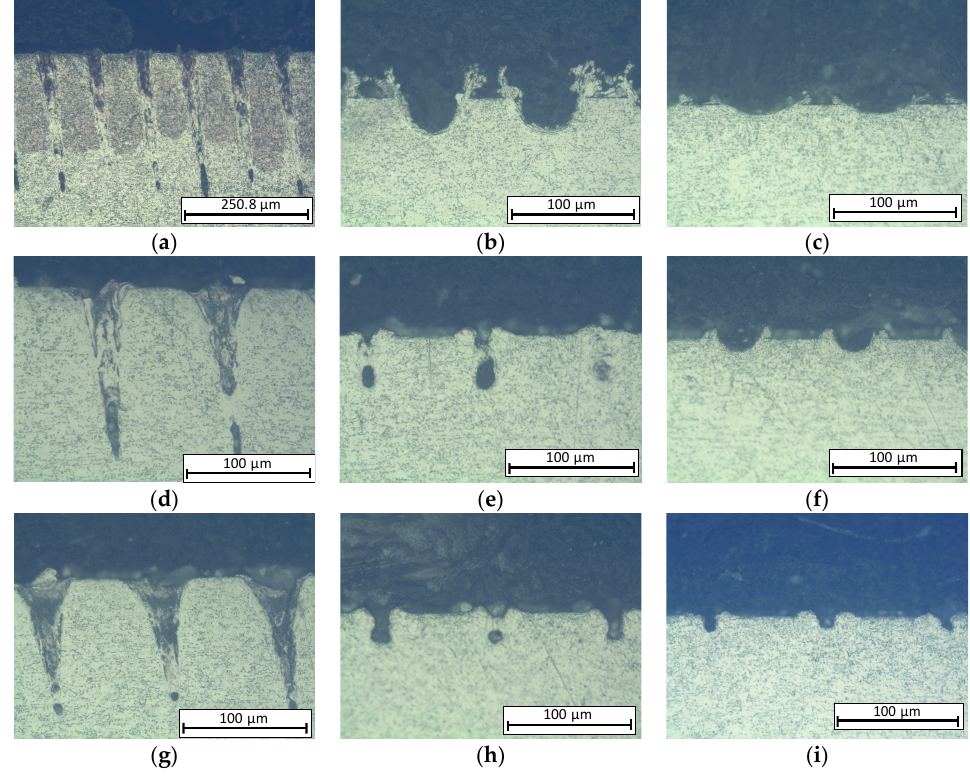
Figure 5. Different morphology of grooves due to laser absorption features. ( a ) 17.68 J/cm 2 , 10 mm/s; ( b ) 17.68 J/cm 2 , 80 mm/s; ( c ) 17.68 J/cm 2 , 250 mm/s; ( d ) 7.07 J/cm 2 , 10 mm/s; ( e ) 7.07 J/cm 2 , 80 mm/s; ( f ) 7.07 J/cm 2 , 250 mm/s; ( g ) 4.42 J/cm 2 , 10 mm/s; ( h ) 4.42 J/cm 2 , 80 mm/s; ( i ) 4.42 J/cm 2 , 250 mm/s.